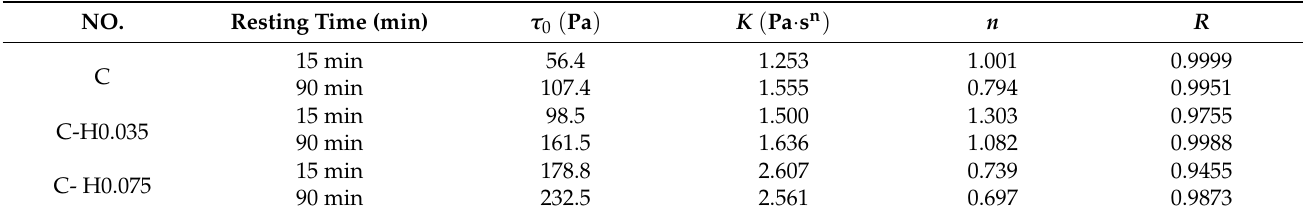
Table 8. Rheological parameters of C-HPMC